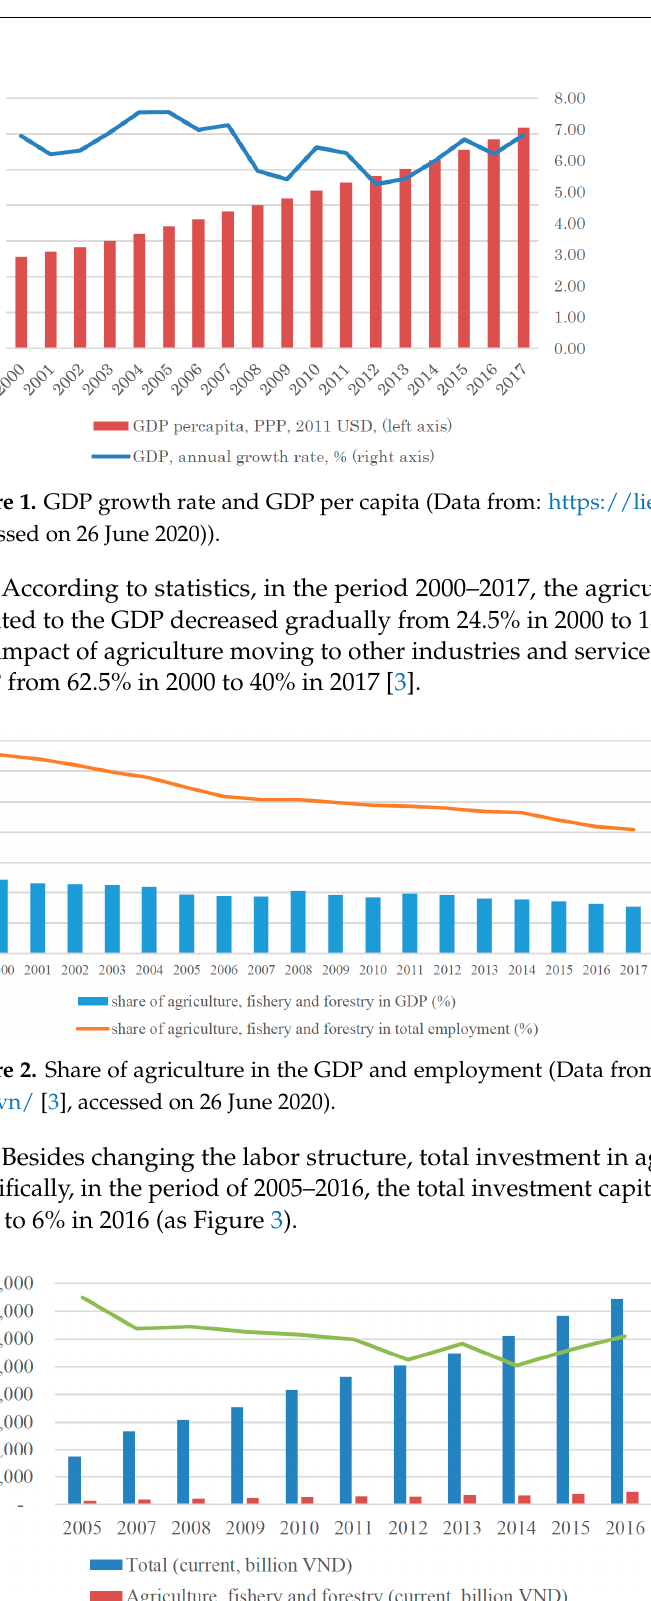
Figure 1. GDP growth rate and GDP per capita (Data from: https://lienvietpostbank.com.vn/ [3] (accessed on 26 June 2020)).